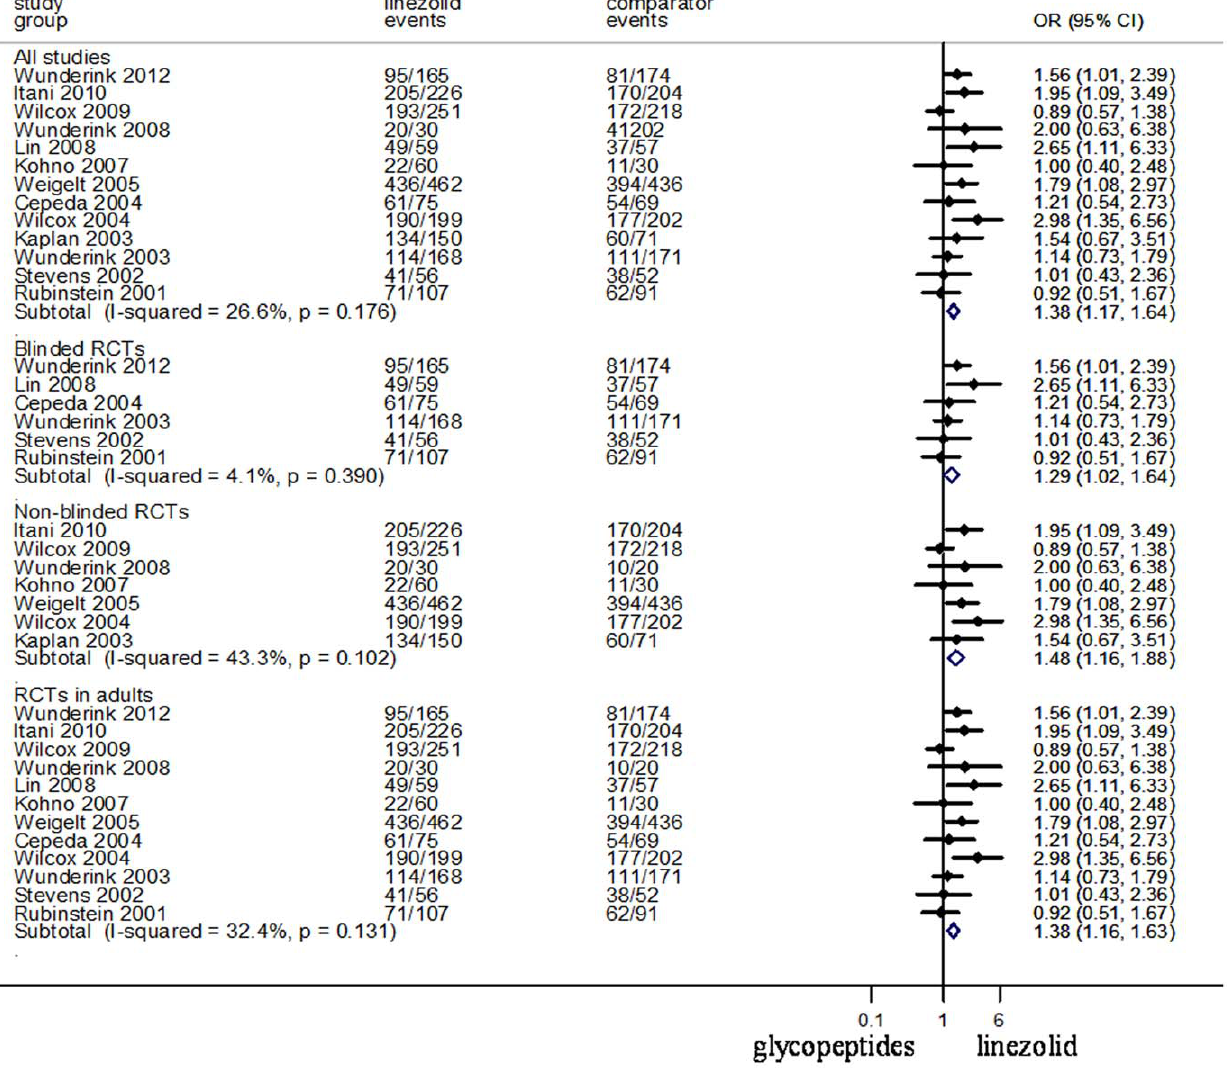
Figure 2. Meta-analyses of treatment success for clinically assessed patients. Test of all studies for overall effect: Z=3.65 P =0.000; test of blinded RCTs for overall effect: Z=2.11 P =0.035; test of Non-blinded RCTs for overall effect: Z=3.03 P =0.002; test of RCTs in adults for overall effect: Z=3.64 P =0.000.